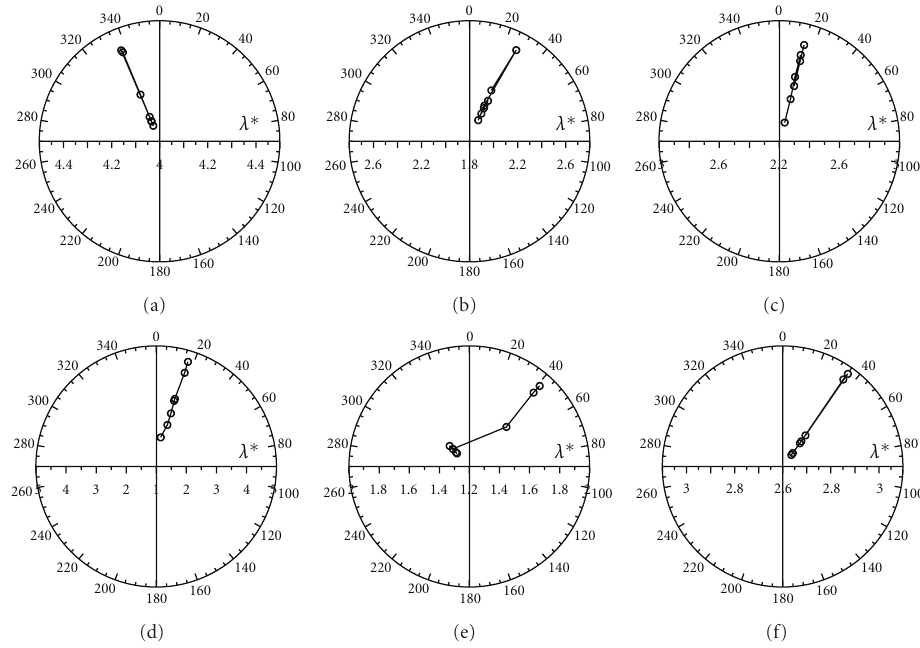
Figure 9: The diagrams of λ ∗ and α with pressure for sample YN2. (a)–(f) represent the diagrams at the e ff ective depths of 2.5 mm, 7.5 mm, 12.5mm, 17.5mm, 22.5 mm, and 27.5 mm e ff ective